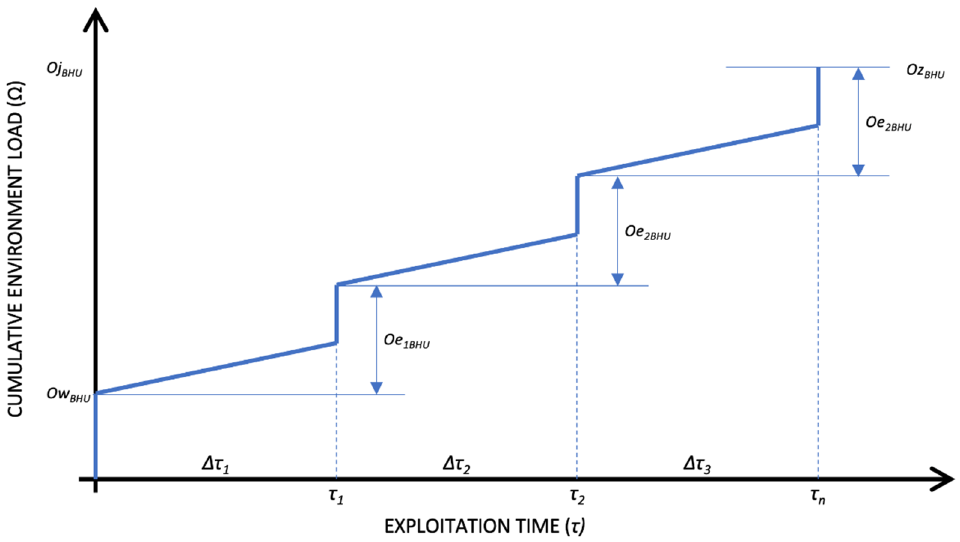
Figure 2. Graph presenting the course of the cumulative environmental load Ω in the life cycle of a retail and service building over time τ . Own study based on